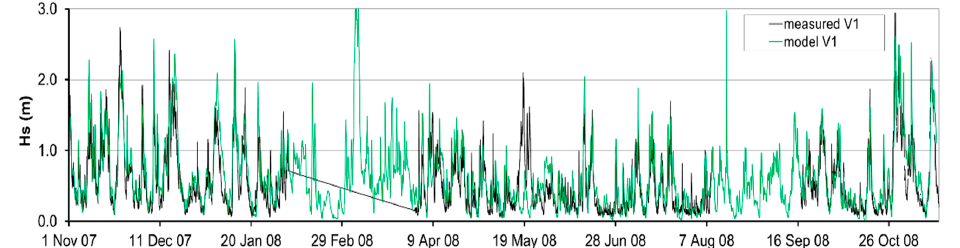
Figure 17. Comparison of measured and modelled time series of significant wave heights Hs at wave measurement station V1 in the northern Adriatic open-sea area ( ϕ = 44°44.57 ′ N, λ = 13°17.98 ′ E).